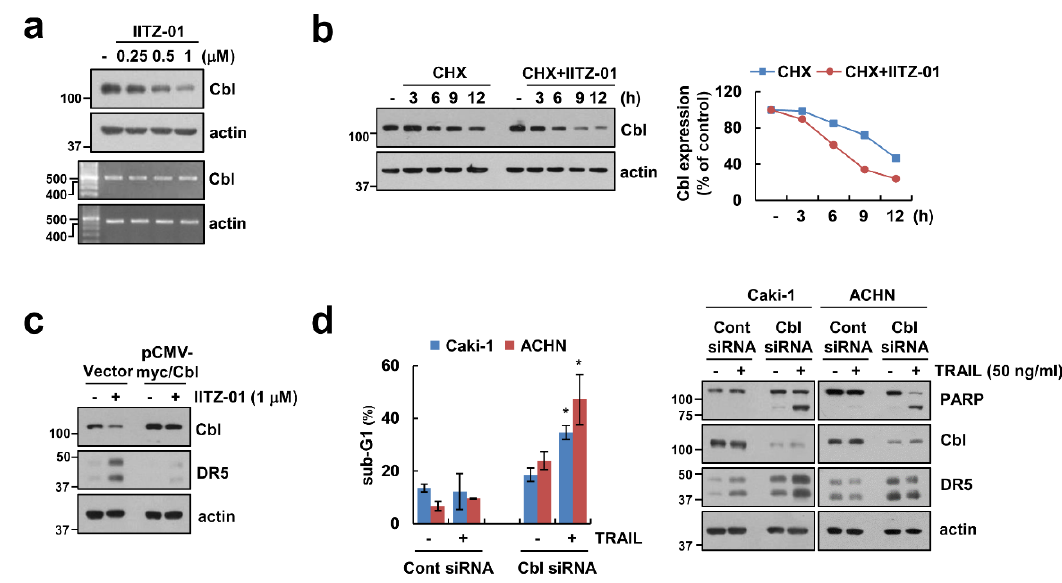
Figure 4. Downregulation of Cbl is involved in IITZ-01-mediated DR5 upregulation and TRAIL sensitization. ( a ) Caki-1 cells were incubated with 0.25–1 µ M IITZ-01 for 18 h. The protein and mRNA levels were determined by Western blotting and RT-PCR, respectively; ( b ) Caki-1 cells were incubated with 20 µ g / mL CHX and / or 1 µ M IITZ-01 for the indicated time periods. The band intensity of the Cbl protein was measured using Image J; ( c ) Caki-1 cells were transfected with pCMV-myc (Vector) or pCMV-myc / Cbl and treated with 1 µ M IITZ-01 for 18 h; ( d ) Caki-1 and ACHN cells were transiently transfected with Cont siRNA or Cbl siRNA, and then incubated with 50 ng / mL TRAIL for 18 h. The apoptotic population (sub-G1) and protein levels were analyzed by flow cytometry ( d ) and Western blotting ( b – d ) , respectively. The values in graph ( d ) represent the mean ± SD of three independent experiments. * p < 0.05 compared to the TRAIL in control siRNA.